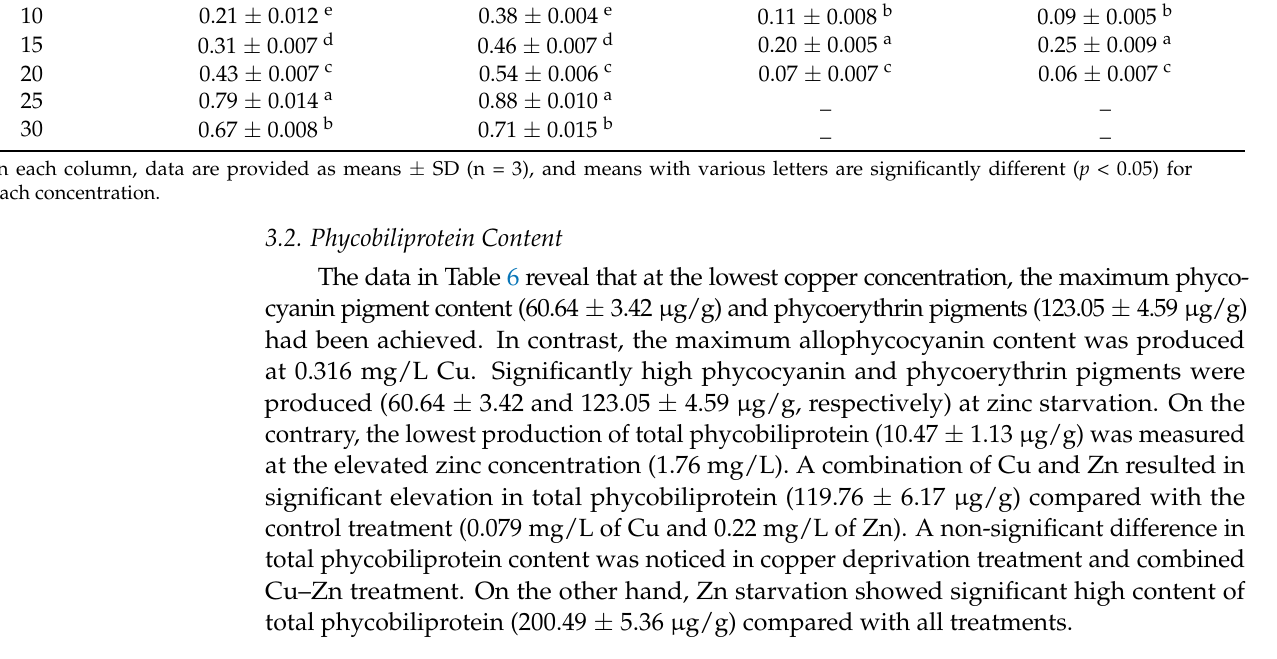
Table 6. Phycobiliprotein content (as µ g/g) for Nostoc linckia grown on various copper and zinc concentrations.